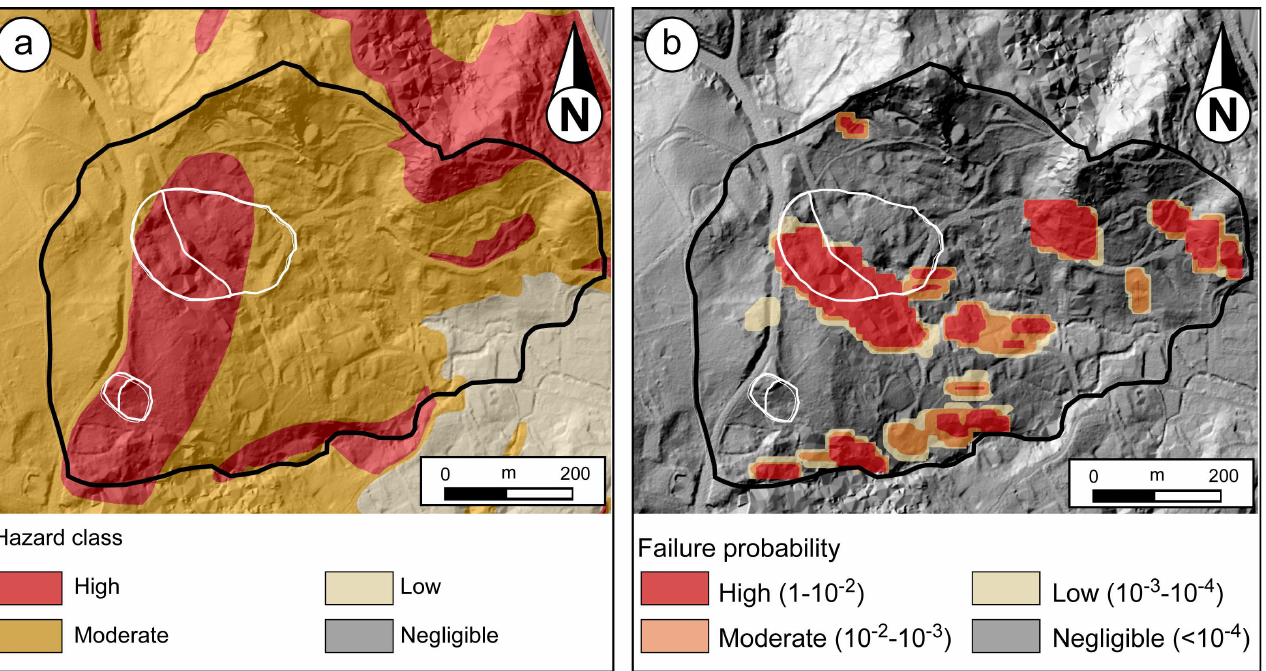
Figure 17. Landslide hazard maps for the Morne-Figue area. ( a ) Expert landslide hazard map obtained by expert approach and carried out at the 1:25,000 scale of work for all landslide types; ( b ) failure probability map obtained with ALICE ® for moderately deep rotational landslides; map computed with GWL = 1; hillshade maps were produced with the Litto3D DTM (IGN,